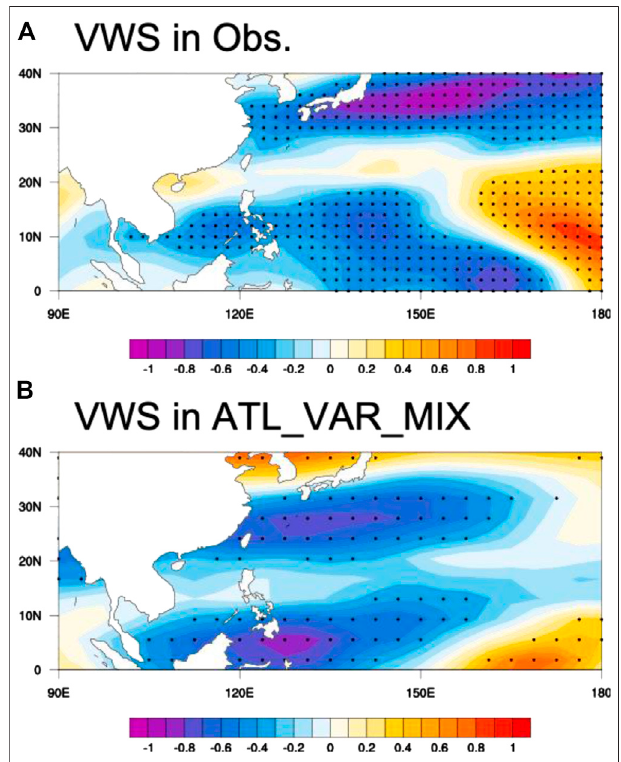
FIGURE 7 | The regression map of vertical wind shear (wind differences between 850 hPa and 200 hPa levels, m/s) anomalies onto the normalized AMO index based on the data from the 20CRv2 for 1950 – 2010. (B) As in (A) , but in the ATL_VARMIX experiment. The long-term linear trends in the data were removed before the regression analysis, and dots indicate the regression coef fi cients signi fi cant at the 95% con fi dence